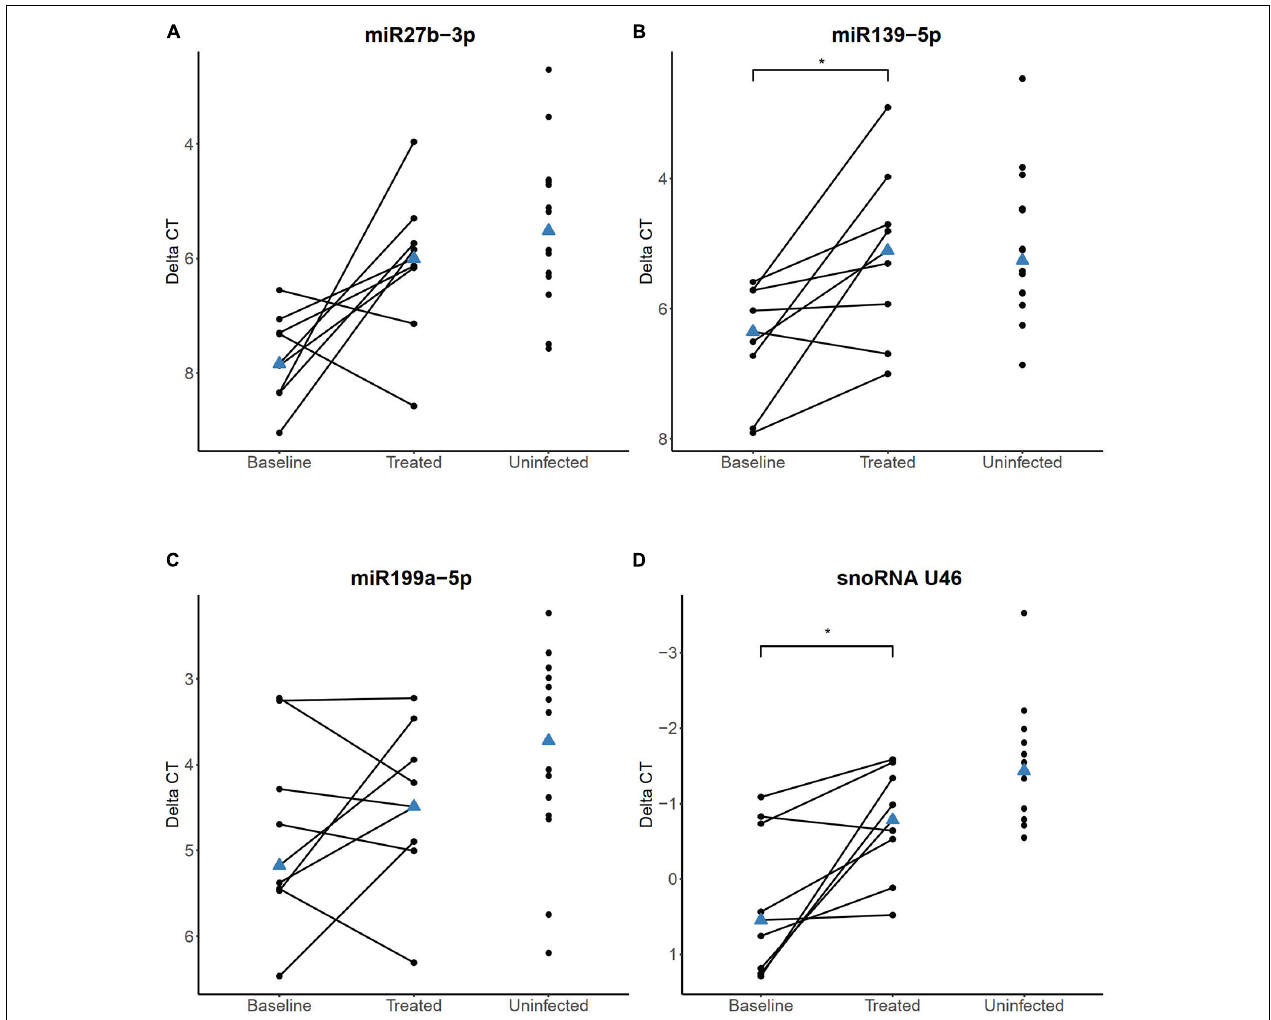
FIGURE 6 | sncRNA expression levels quantified by RT-qPCR in HIV+/TB+ study participants before and after the initiation of anti-tuberculosis treatment and antiretroviral treatment (A) miR-27, (B) miR-139-5p, (C) miR-199a-5p, and (D) snoRNA U46. Paired samples of participants longitudinally followed before and during treatment are connected with a line. HIV-/TB- control group is included in all plots for comparison. The blue triangle indicates the median value. *Adjusted P < 0.05. P- values were calculated from paired samples Wilcoxon test with Holm-Bonferroni